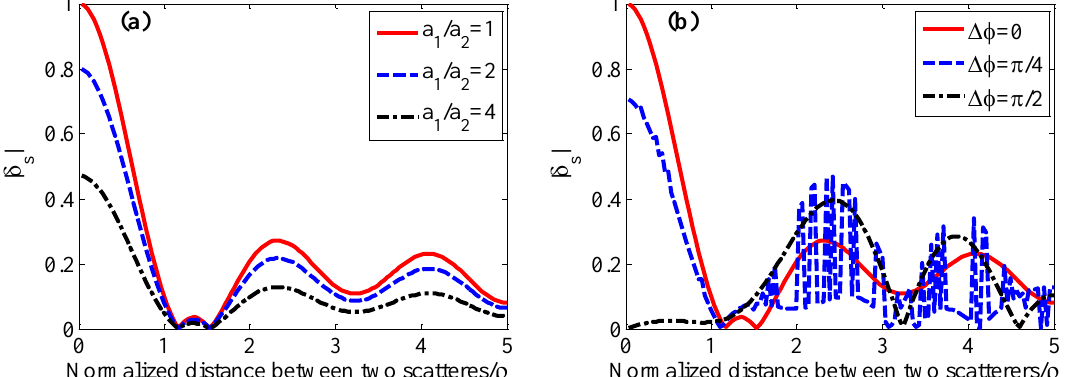
Figure 5. RIP property of two scatterers versus scatterer distance (normalized to ρ s ) under different: ( a ) magnitude ratio with red solid, blue dashed and black dotted-dashed denoting a 1 / a 2 = 1,2,4, respectively; and ( b ) phase difference with red solid, blue dashed and black dotted-dashed denoting ∆ φ = 0, π /4, π /2 , respectively. It should be noted that SNR 1 = 10 dB and ( a ), and SNR 1 = SNR 2 = 10 dB in ( b ). δ s refers to Equation (15).